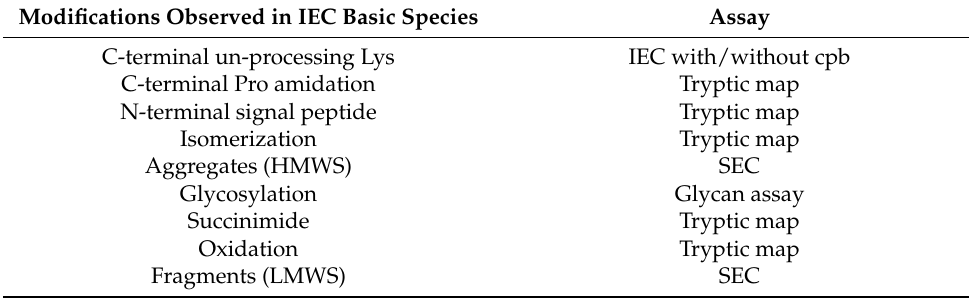
Table 3. Recommended Assays to Monitor and Quantify Basic